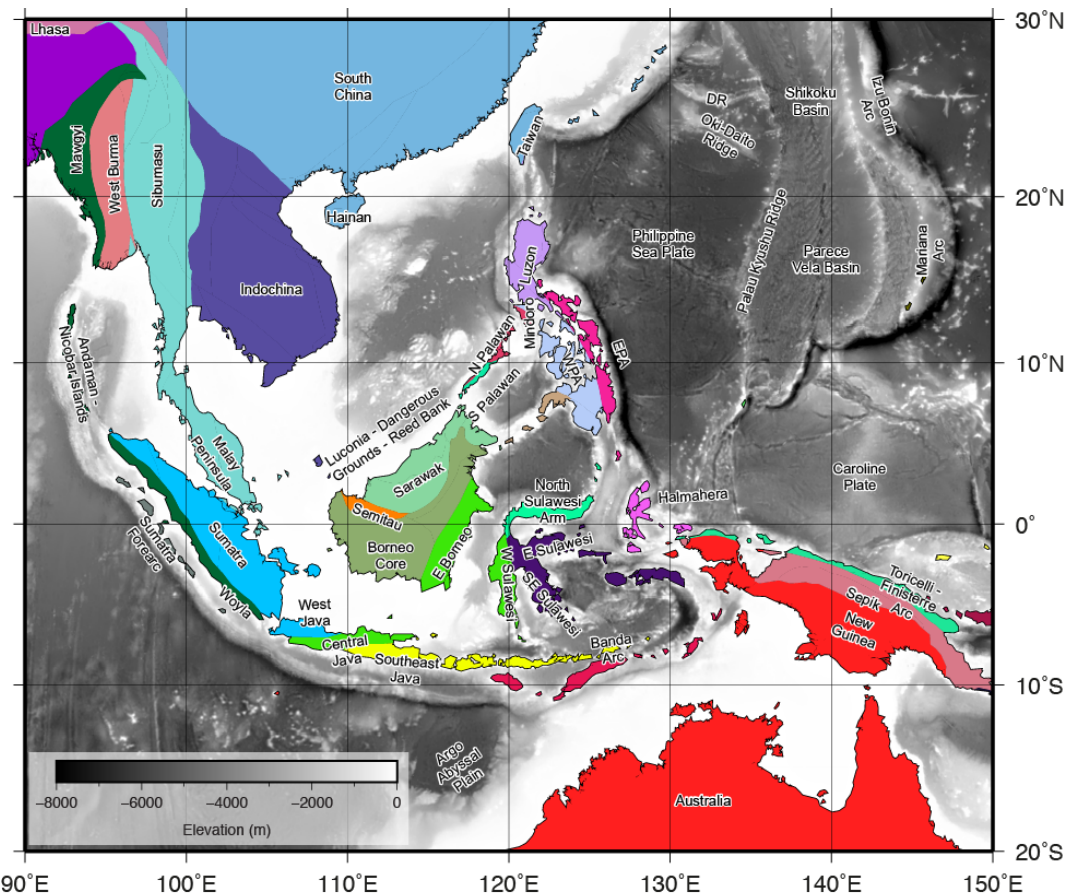
Fig. 12a. Present-day distribution of blocks and tectonic features (including oceanic basins, arcs and ridges) related to the long-term conver- gence of the Eurasian, Indo-Australian and Pacific plates. Tectonic elements are color-coded by their tectonic affinities. The colors can help track the motion of tectonic elements through time in Fig. 12b and the animation in the Supplement. Grey shading is ETOPO-1 bathymetry (Amante et al., 2009). DR–Daito Ridge, WPA–West Philippine Arc, EPA–East Philippine Arc.